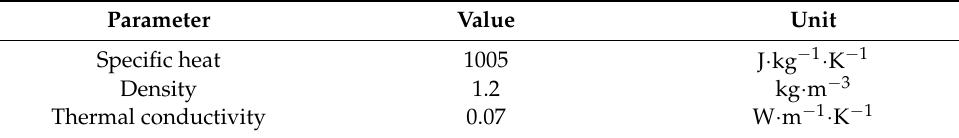
Table 2. Thermal properties of air.